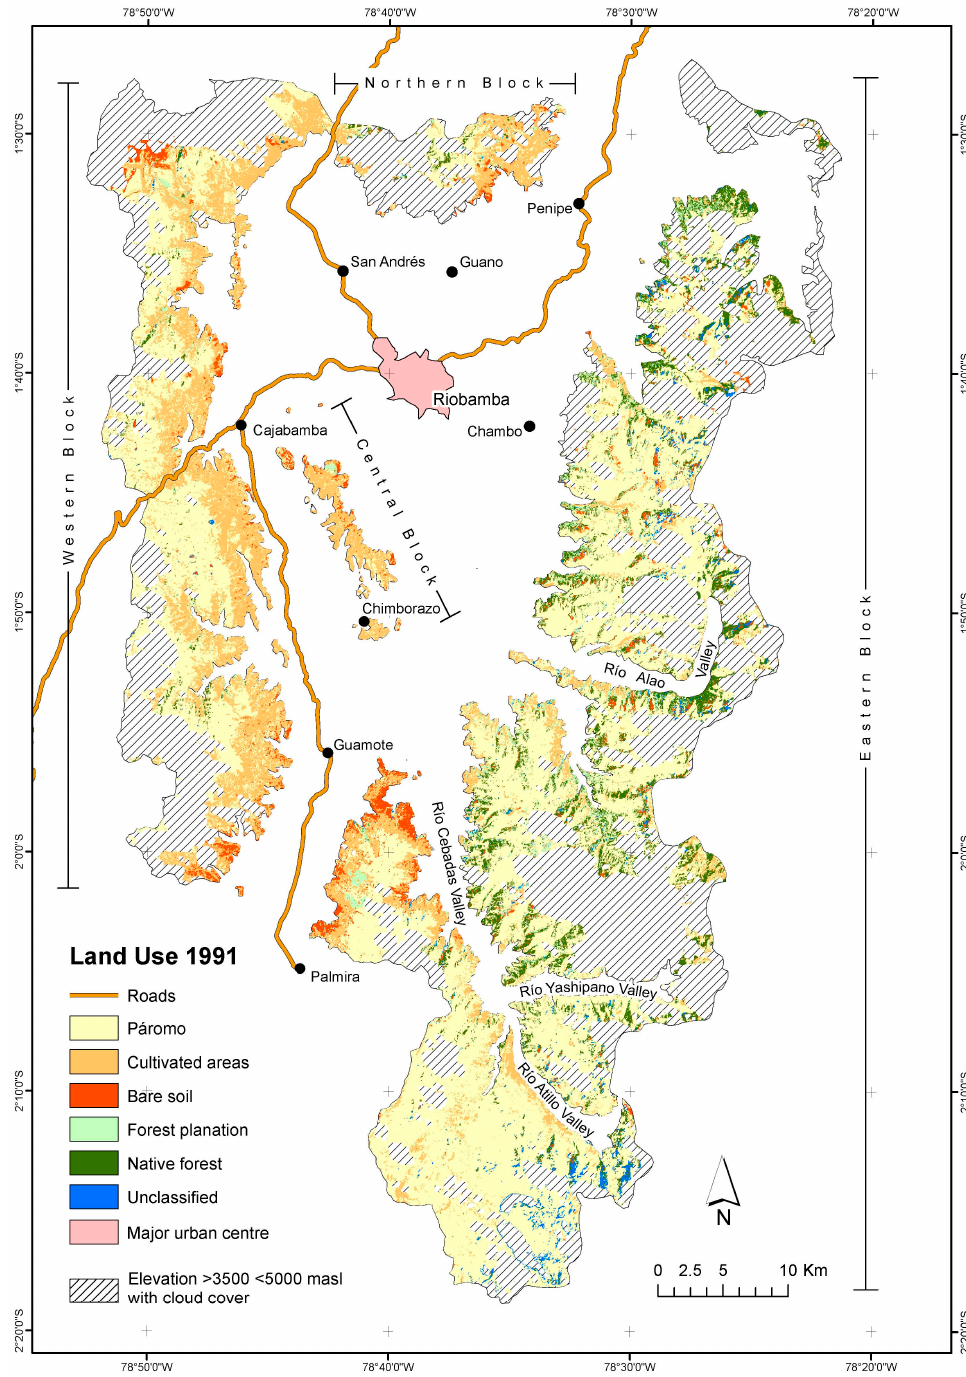
Figure 3. Chambo Basin: land-use, 1991.